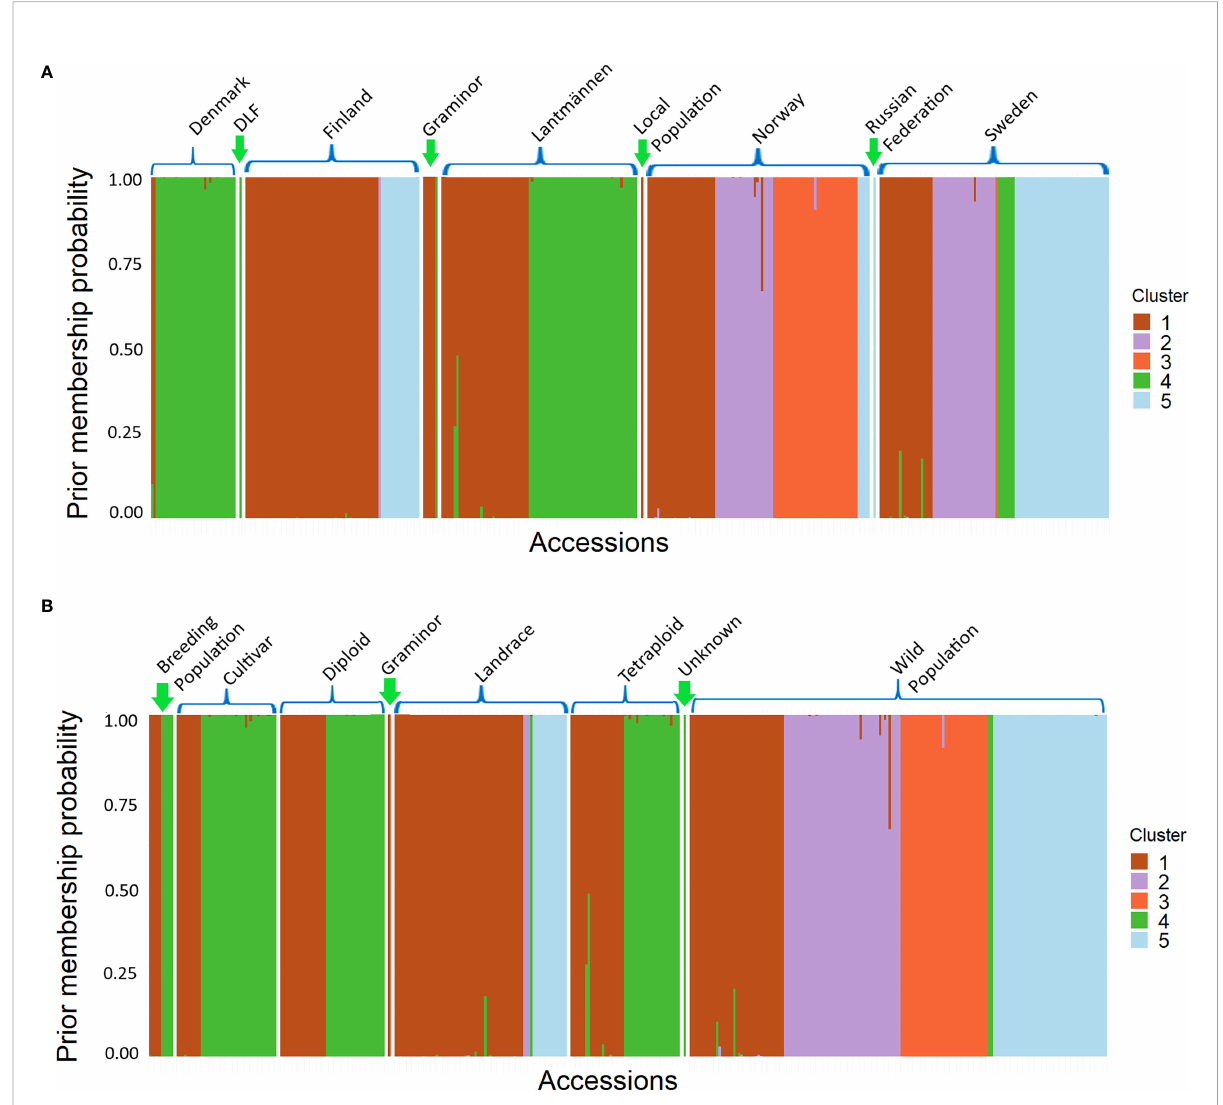
FIGURE 6 A Structure-like membership probability graph showing individual populations of different groups, classi fi ed according to (A) their origin and (B) their population type, assigned to a